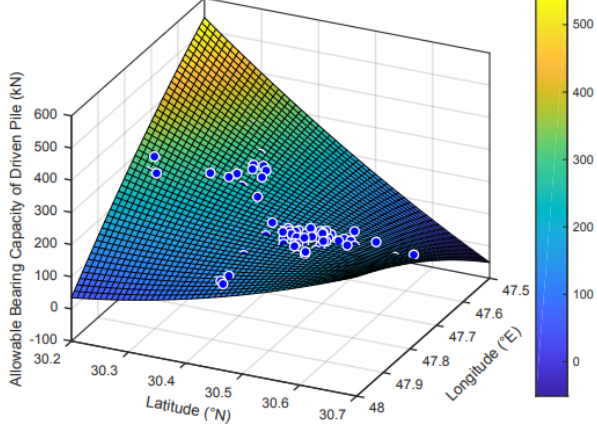
Figure 4: Variation of the allowable bearing capacity of driven piles (6 m length) using 2 nd order polynomial